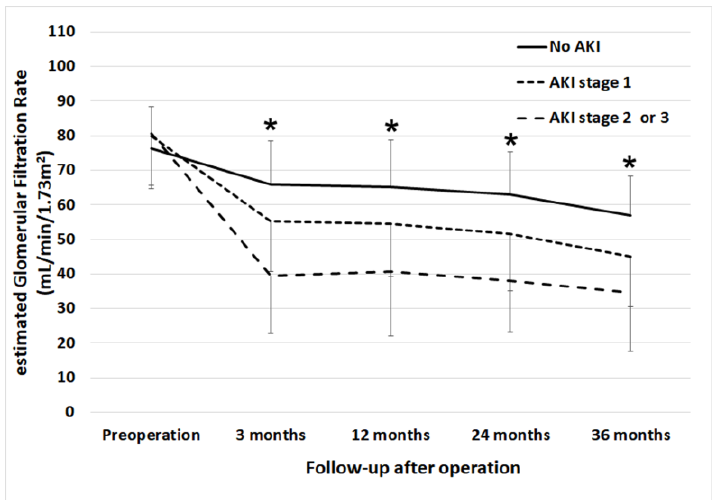
Figure 1. Serial change in mean estimated glomerular filtration rate before surgery to three years after surgery according to the stages of acute kidney injury. * Significant difference between groups.